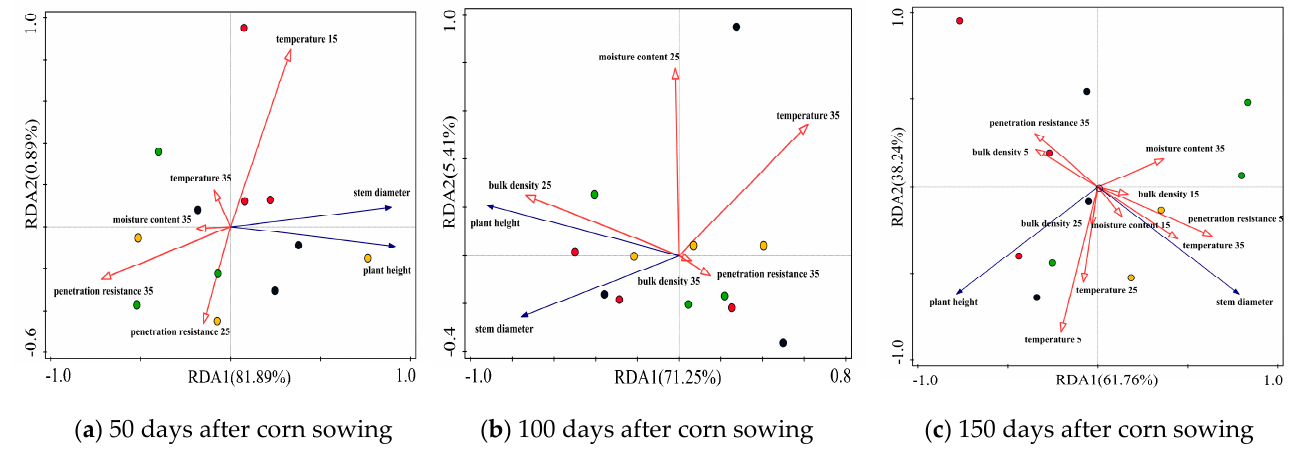
Figure 7. RDA two-dimensional ranking diagram of plant characters and soil physical properties. Note: SPR 5, 15, 25, and 35 are, respectively, mean soil penetration resistance in 5 cm,15 cm, 25 cm, and 35 cm; Moisture content 5, 15, 25, and 35 are, respectively, mean soil moisture content in 5 cm, 15 cm, 25 cm, and 35 cm; Temperature 5, 15, 25, and 35 are, respectively, mean soil temperature in 5 cm, 15 cm, 25 cm, and 35 cm; Bulk density 5, 15, 25, and 35 are, respectively, mean soil bulk density in 5 cm, 15 cm, 25 cm, and 35 cm. The same below.